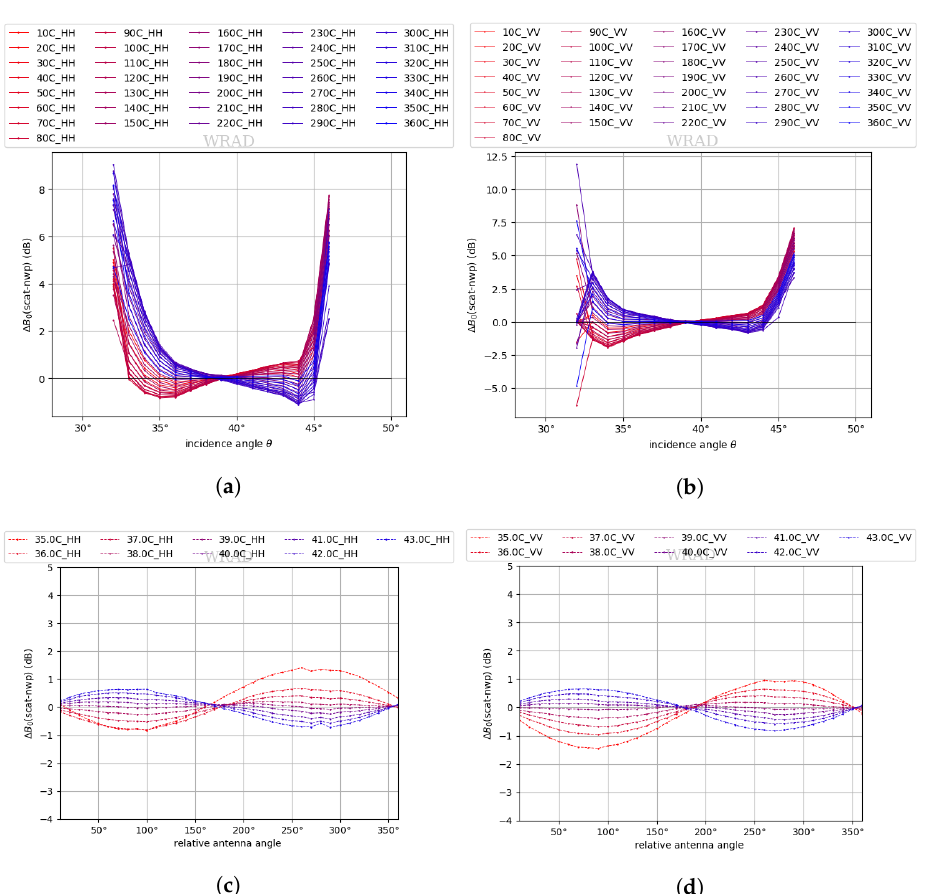
Figure 10. C-band NOCant (NOC as a function of incidence angle and relative antenna angle) for ascending orbits. The upper panel is as a function of incidence angle ( x -axis) per relative antenna angle (red to blue lines), the lower panel is as a function of relative antenna angle ( x -axis) per incidence angle (red to blue lines): ( a , c ) HH polarization; ( b , d ) VV